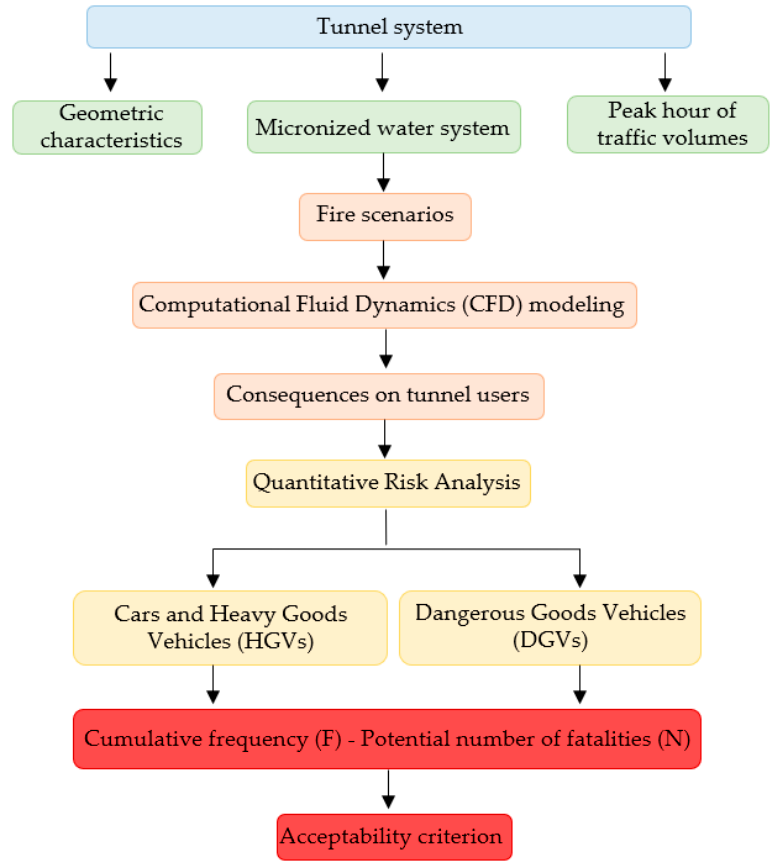
Figure 4. Flow chart of the methodology.